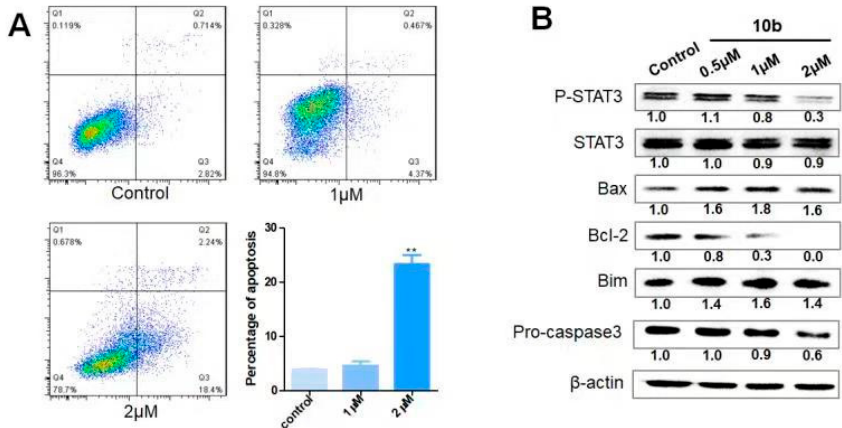
Figure 2. ( A ) The representative images and the statistical results of flow cytometry after treatment with compound 10b at 0, 1, and 2 µ M in a cell apoptosis assay. ** p < 0.01. ( B ) The level of STAT3, P-STAT3, Bax, Bim, Bcl-2, and caspase 3 after treatment with compound 10b at different concentrations by a Western blot